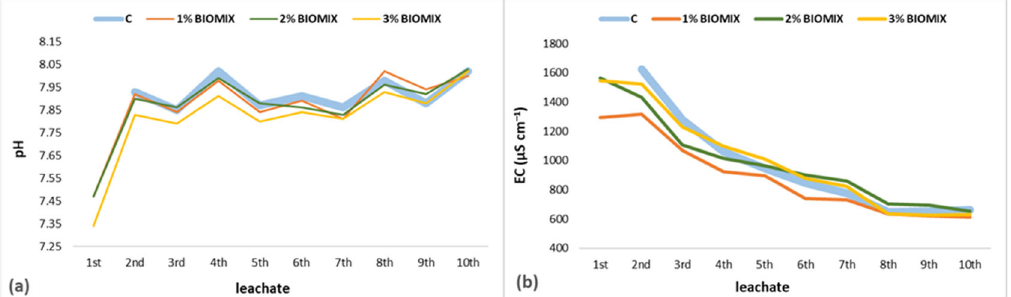
Figure 1. Changes of: ( a ) pH values and ( b ) EC values in the leachates of the 10 irrigation applications of the four treatments. Each value is the mean of three replicates.